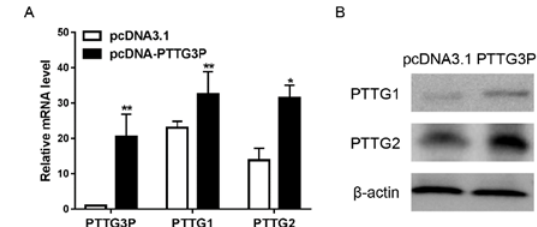
Figure 5: Effect of overexpression of PTTG3P on PTTG1 and PTTG2 in KYSE140 cells A. mRNA expression levels of PTTG1 and PTTG2 in PTTG3P-overex- pressing cells were evaluated by qRT–PCR, GAPDH was used as an internal control; B. Protein expression levels of PTTG1 and PTTG2 in PTTG3P-overexpressing cells were evaluated by Western blotting, β-actin was used as an internal control; Data are shown as the mean ± SD of three replicates; *P<0.05; ** P<0.01.